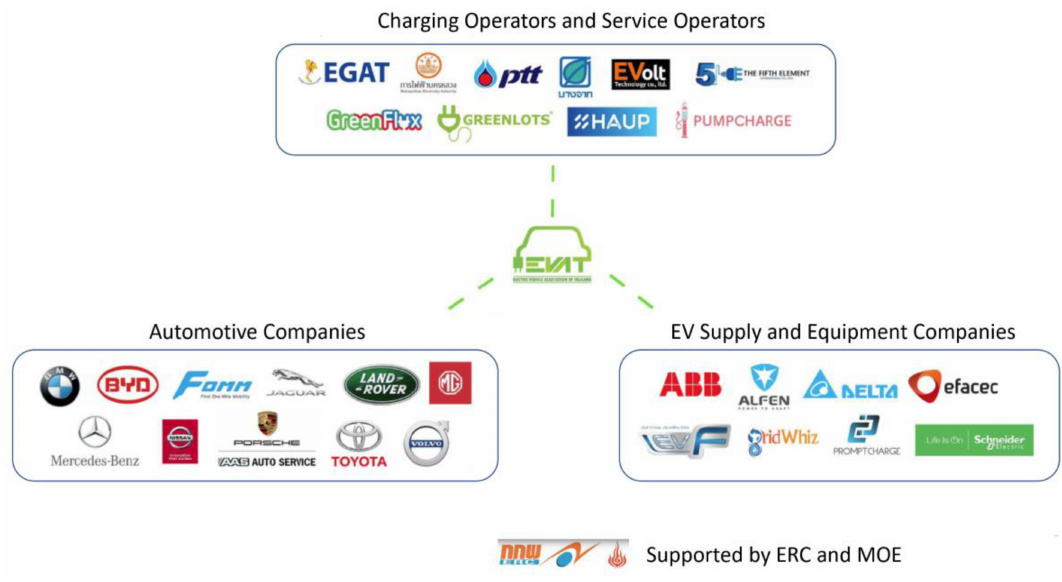
Figure 2. EV Charging Consortium. Source: